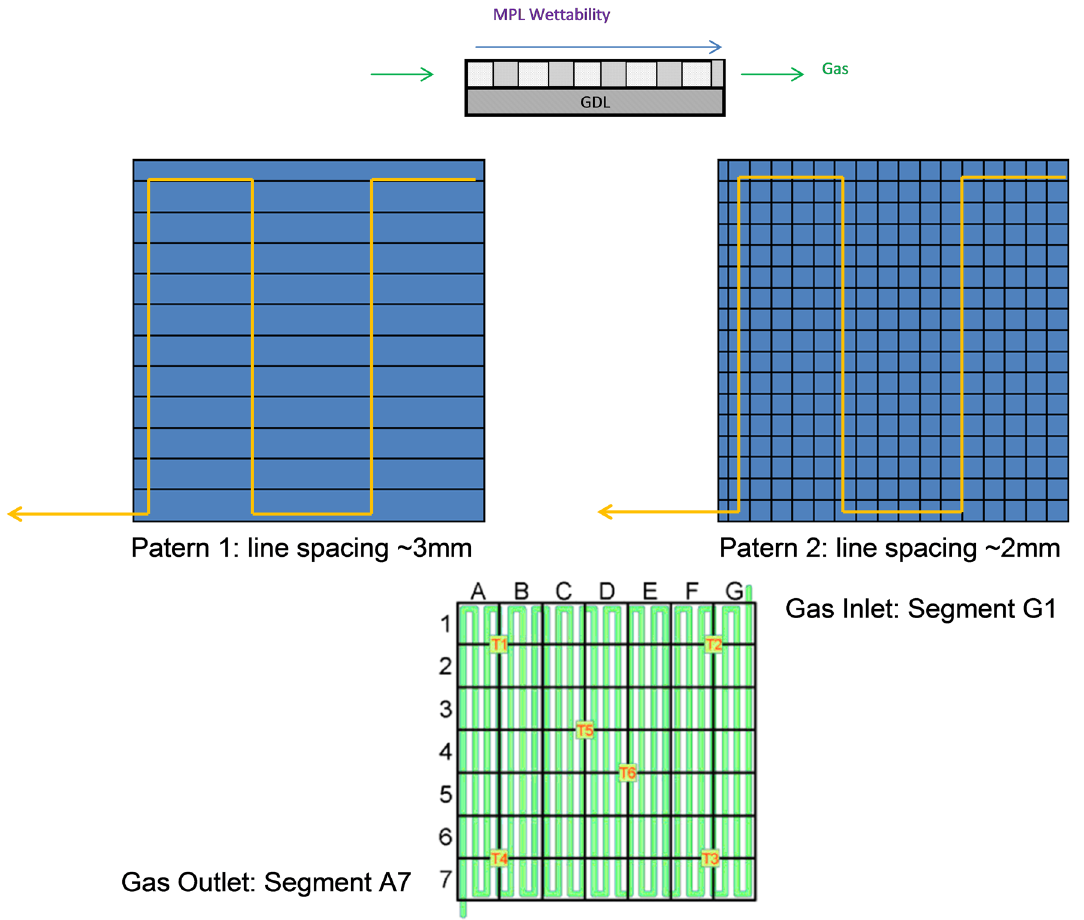
Fig. 1 Hydrophobicity patterns performed with a focused laser beam. The green pattern is a scheme of the flow field of the segmented board, the temperature sensors and the 7 9 7 segments are labeled (detailed description in